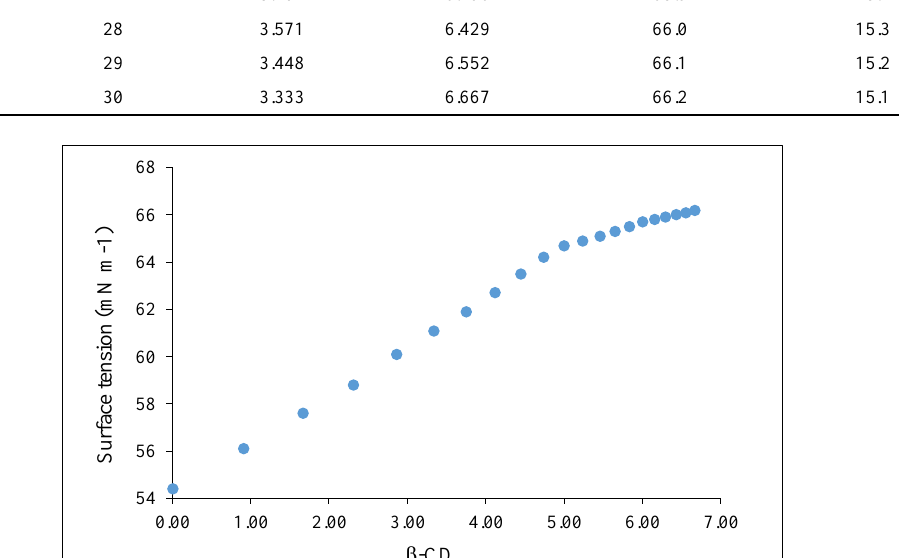
Figure 6. Variation of surface tension of aqueous PNB solution with increasing concentration of β-CD at